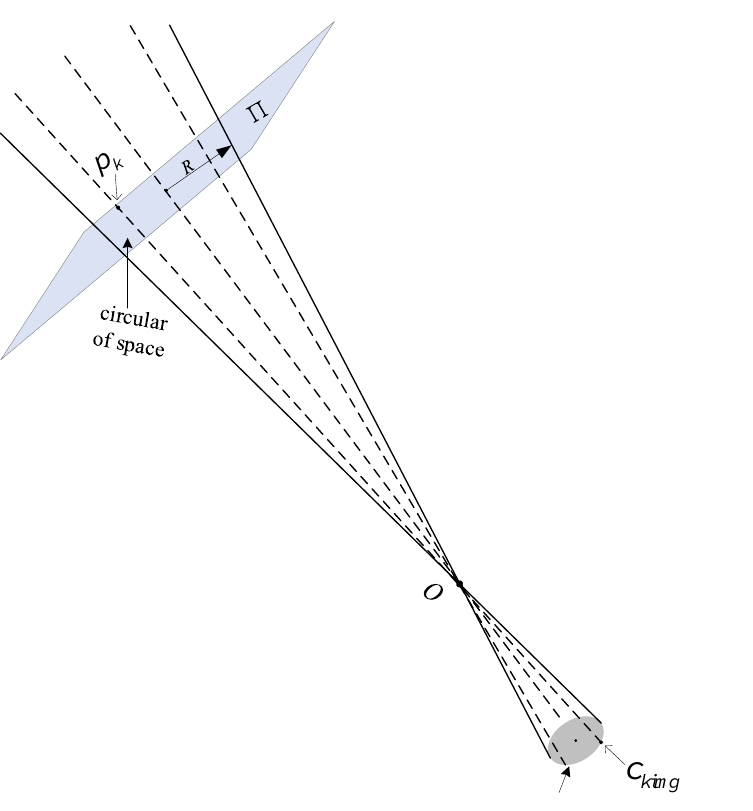
Figure 3. Back-projection of image elliptical contour points .